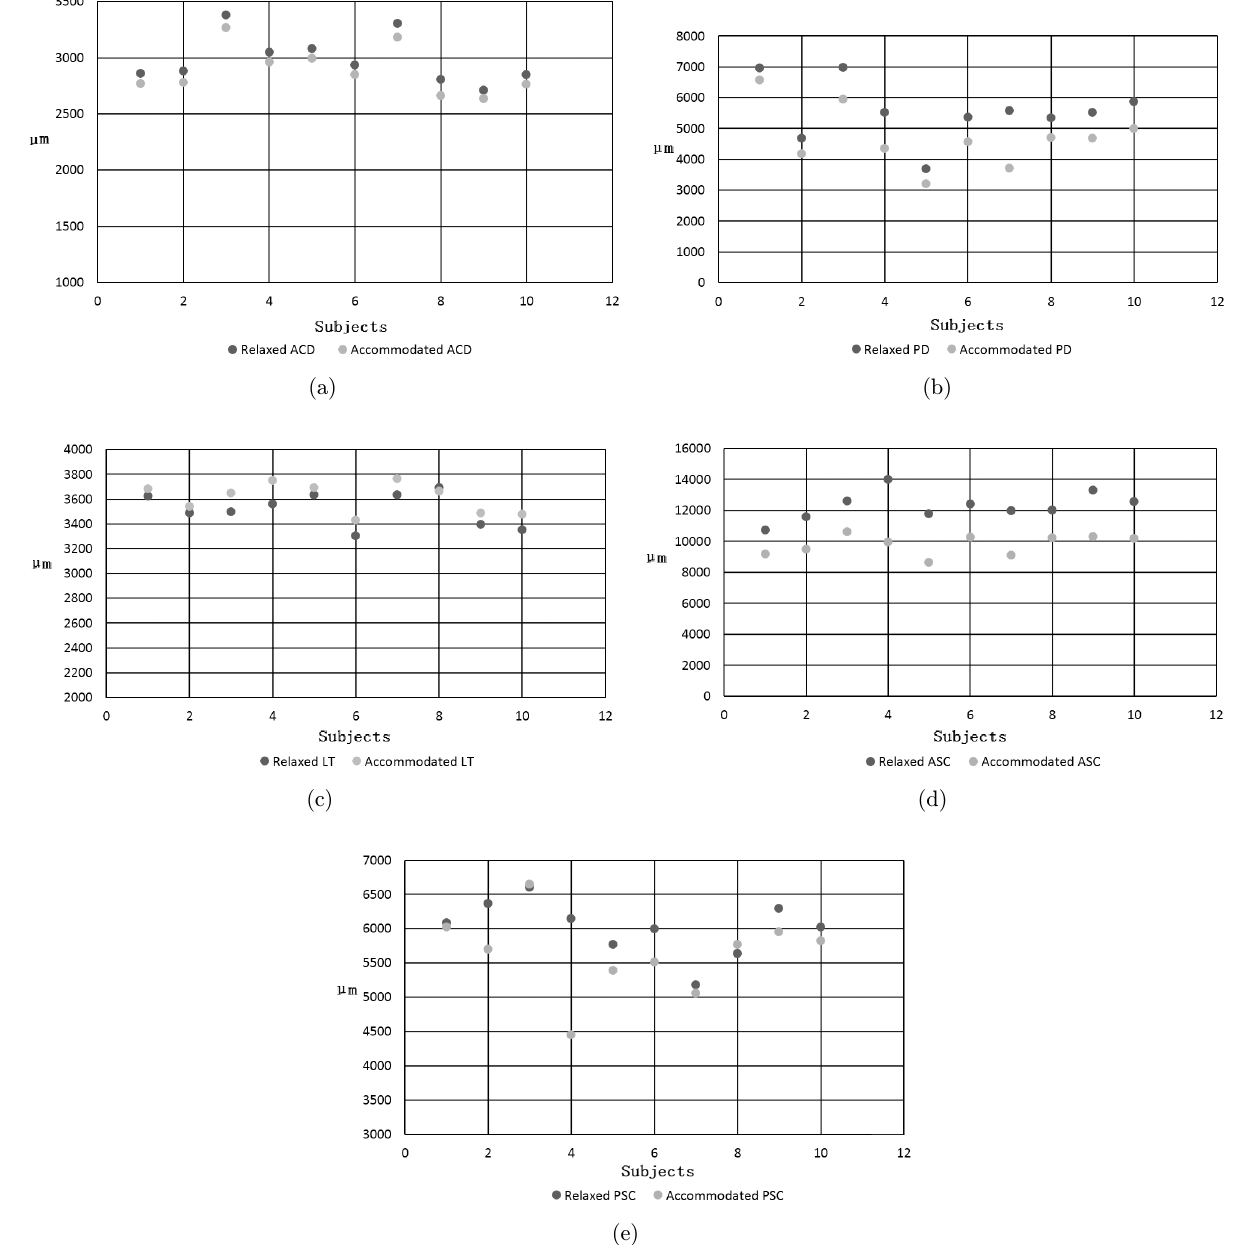
Fig. 4. Changes in biometric dimensions. ACD: anterior chamber depth; PD: pupil diameter; LT: lens thickness; ASC: crystalline lens's anterior surface curvature; PSC: crystalline lens's posterior surface